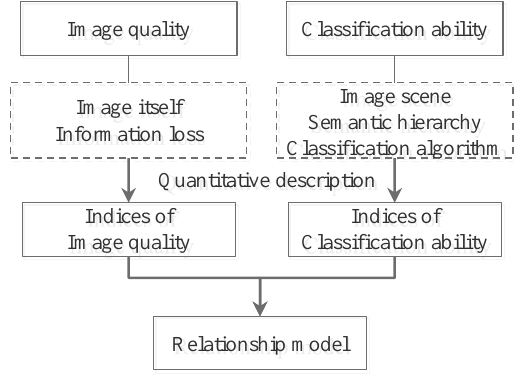
Figure 2. Framework for the relationship exploration of the image quality and classification ability.